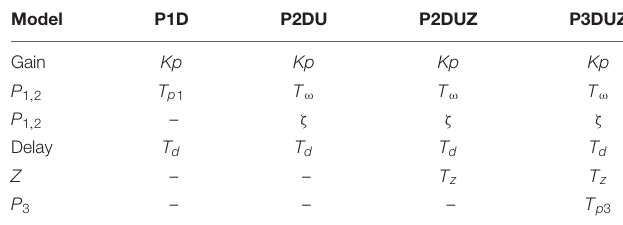
TABLE 2 | Model parameters to describe the relationship between ISI and